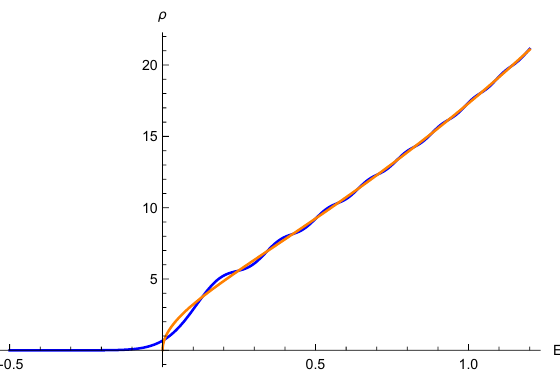
Figure 6 . Plot of (cid:26) partial ( E ) for ~ = 1 = 30. The blue curve represents (cid:26) partial ( E ) in (B.3) while the orange curve represents the genus-zero eigenvalue density (cid:26) 0 ( E ) in (2.97). This is expected since Z ( (cid:12) ) in (B.2) reduces in the limit ~ ! 0 to the genus-zero part partial of Z in JT